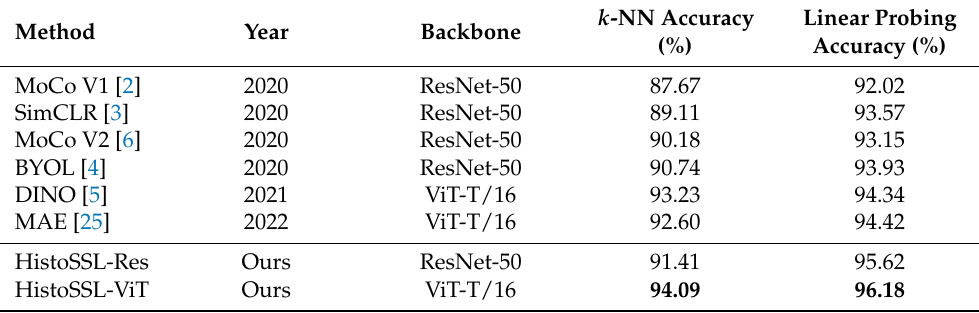
Table 5. Comparing our proposed method with the state-of-the-art frameworks on colorectal tissue phenotyping using the NCTCRC dataset.